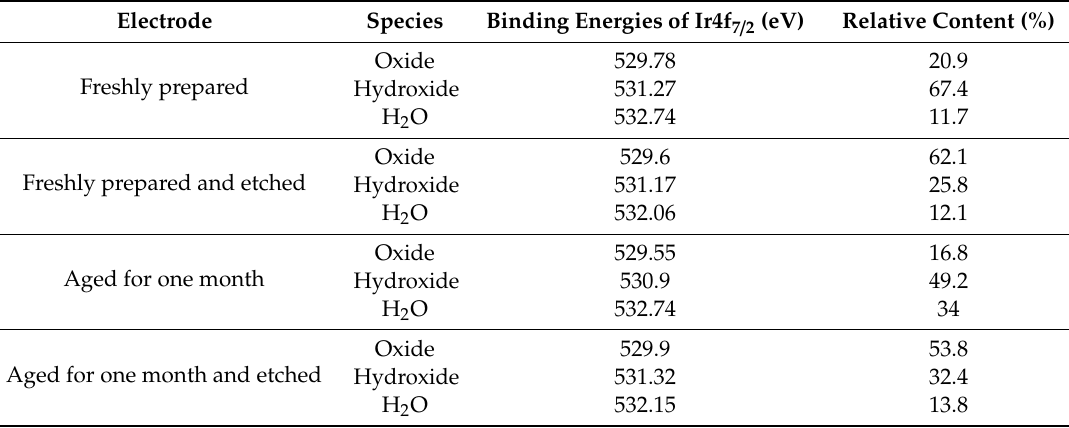
Table 3. Atomic-ratio of Ir 3+ /Ir 4+ and O1s/Ir4f.